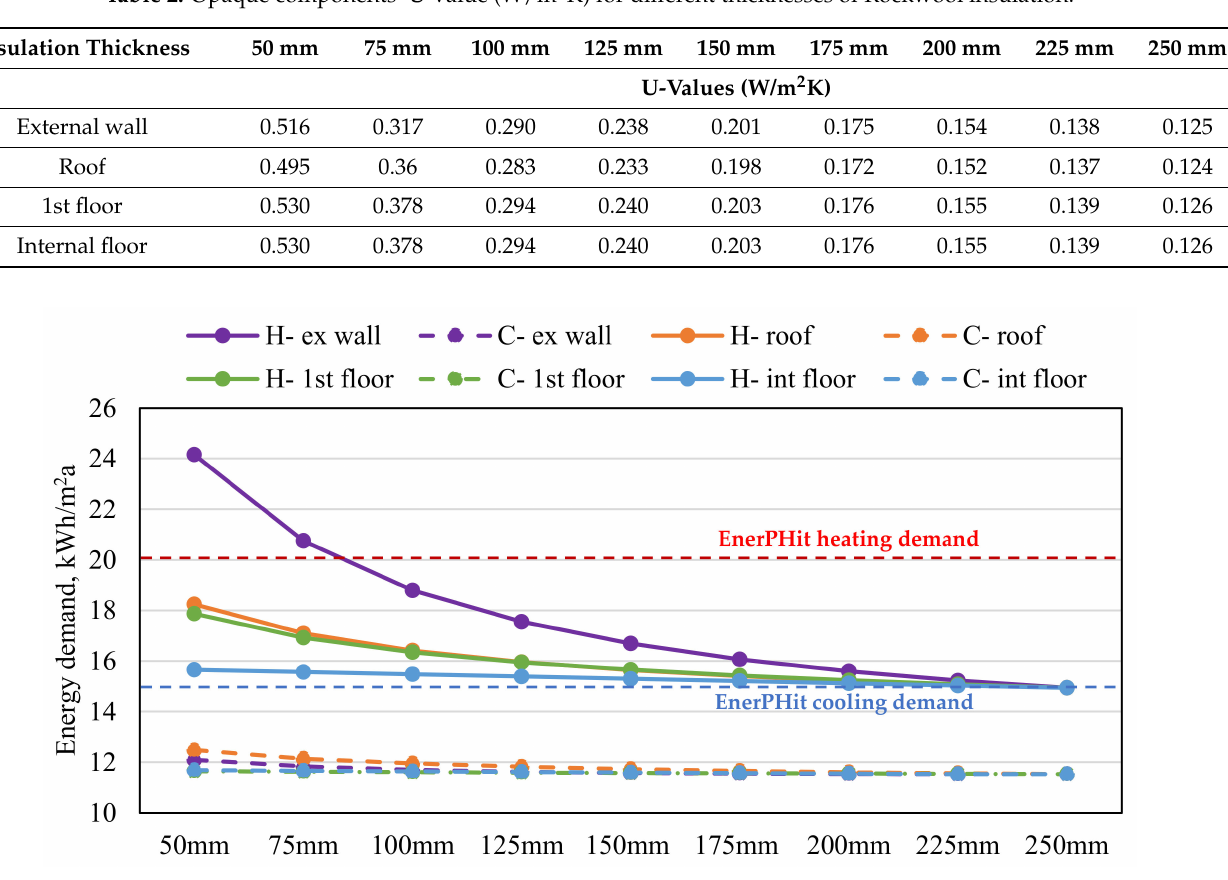
Figure 5. Parametric analysis for each opaque envelope components insulation thickness—impact on the building’s heating (H) and cooling (C)